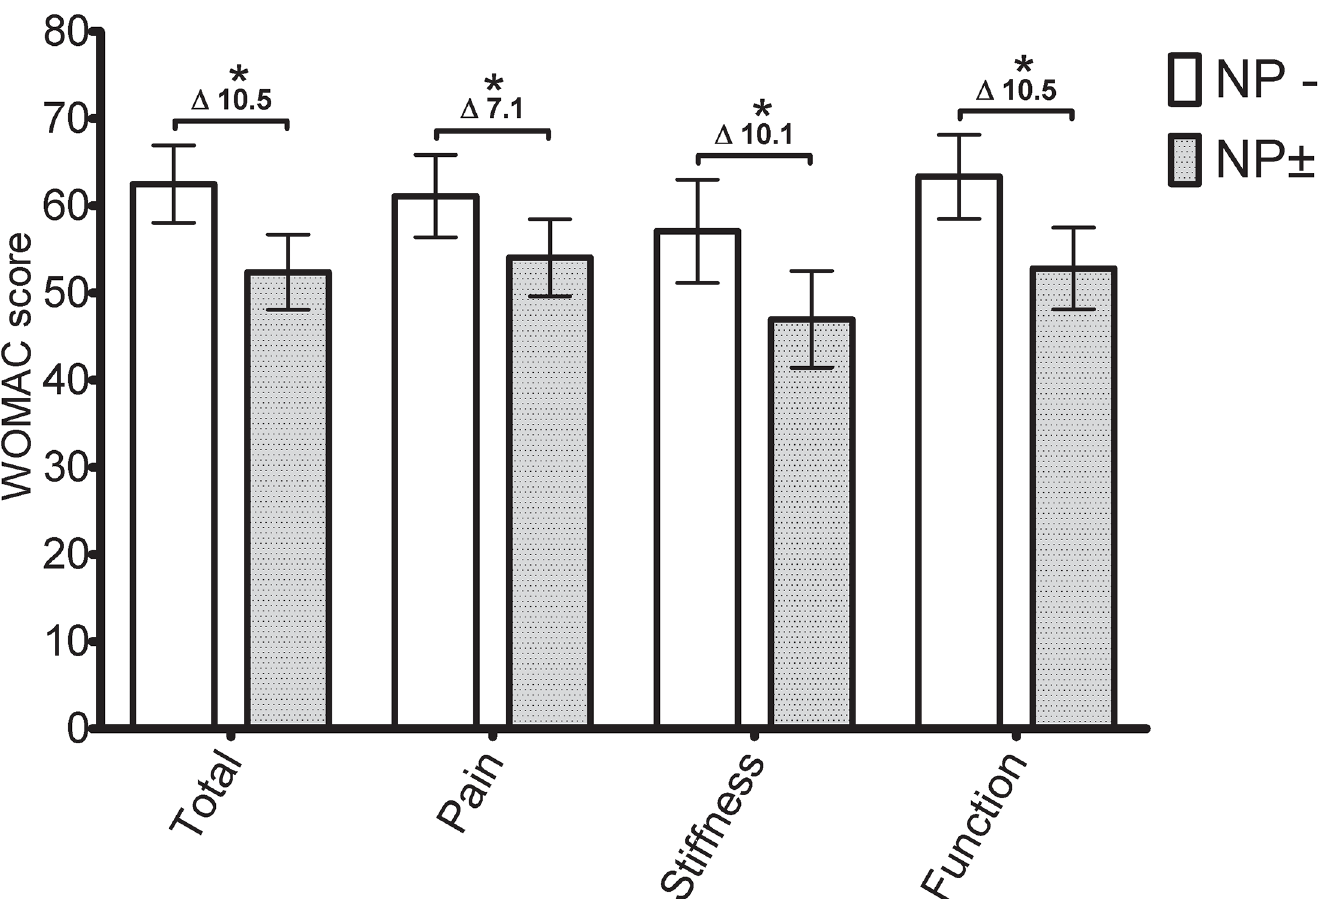
Fig 3. Knee OA Model 3: Fully ANCOVA adjusted WOMAC scores. NP-: unlikely neuropathic pain phenotype (mPDQ (cid:20) 12). NP ± : possible neuropathic pain phenotype (NP ± , mPDQ > 12). WOMAC score 100 indicates no symptoms/problems and 0 indicates extreme symptoms/problems. Error bar represents the 95% CI (lower-upper limits) of the adjusted mean. Mean adjusted difference is displayed numerically. (cid:3) : p < 0.05.